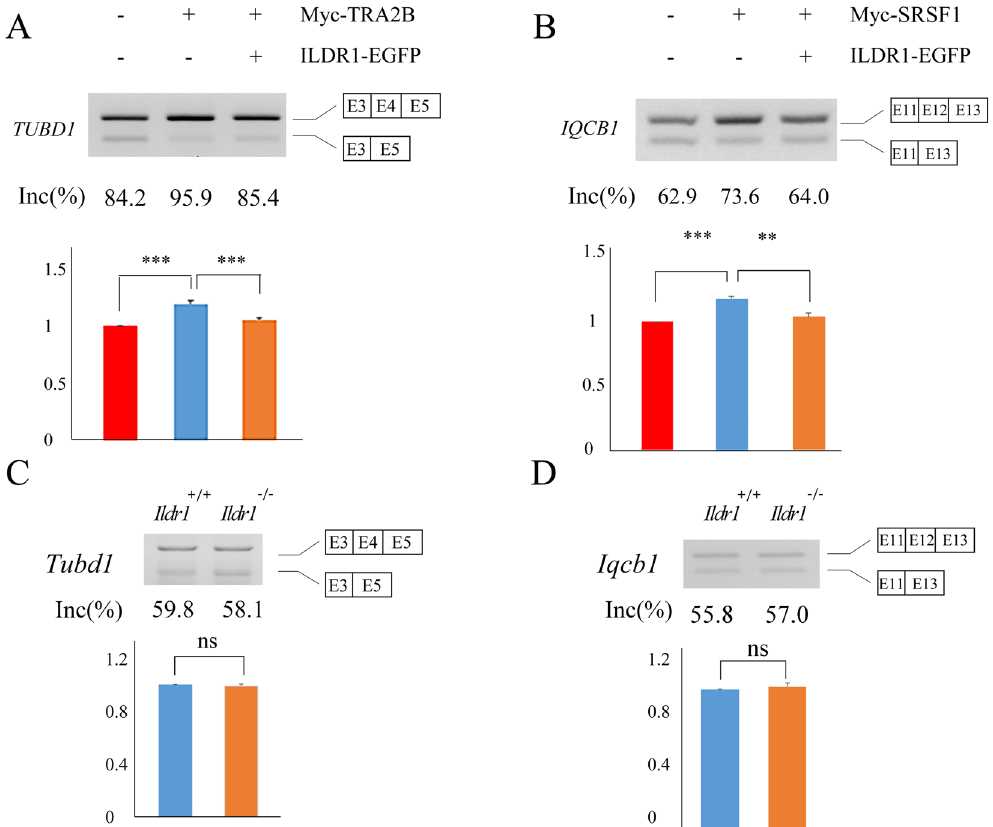
Figure 3. TUBD1 and IQCB1 pre-mRNA splicing is affected by ILDR1. ( A ) RT-PCR revealed that exon 4 of endogenous TUBD1 in HEK293T cells is subjected to alternative splicing (lane 1). The inclusion of exon 4 is enhanced by TRA2B (lane 2), whose effect is inhibited when ILDR1 is present (lane 3). ( B ) RT-PCR revealed that exon 12 of endogenous IQCB1 in HEK293T cell is subjected to alternative splicing (lane 1). The inclusion of exon 12 is enhanced by SRSF1 (lane 2), whose effect is inhibited when ILDR1 is present (lane 3). ( C ) The alternative splicing of Tubd1 exon 4 was not affected in Ildr1 knockout mice. ( D ) The alternative splicing of Iqcb1 exon 12 was not affected in Ildr1 knockout mice. The relative exon inclusion rate was calculated from three independently performed experiments. The differences between groups were determined by Student’s t-test. ** P < 0.01; *** P < 0.001; ns, not